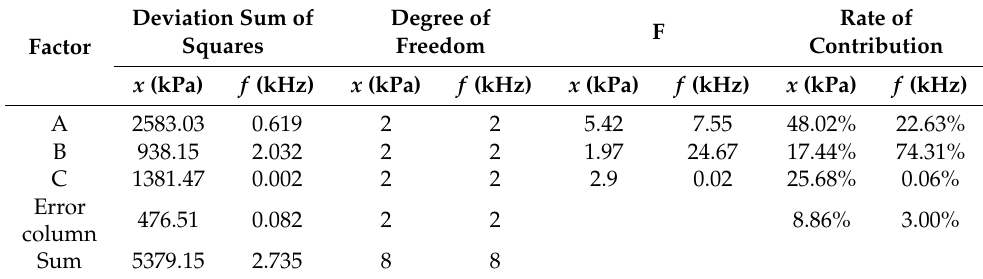
Table 6. Analysis of